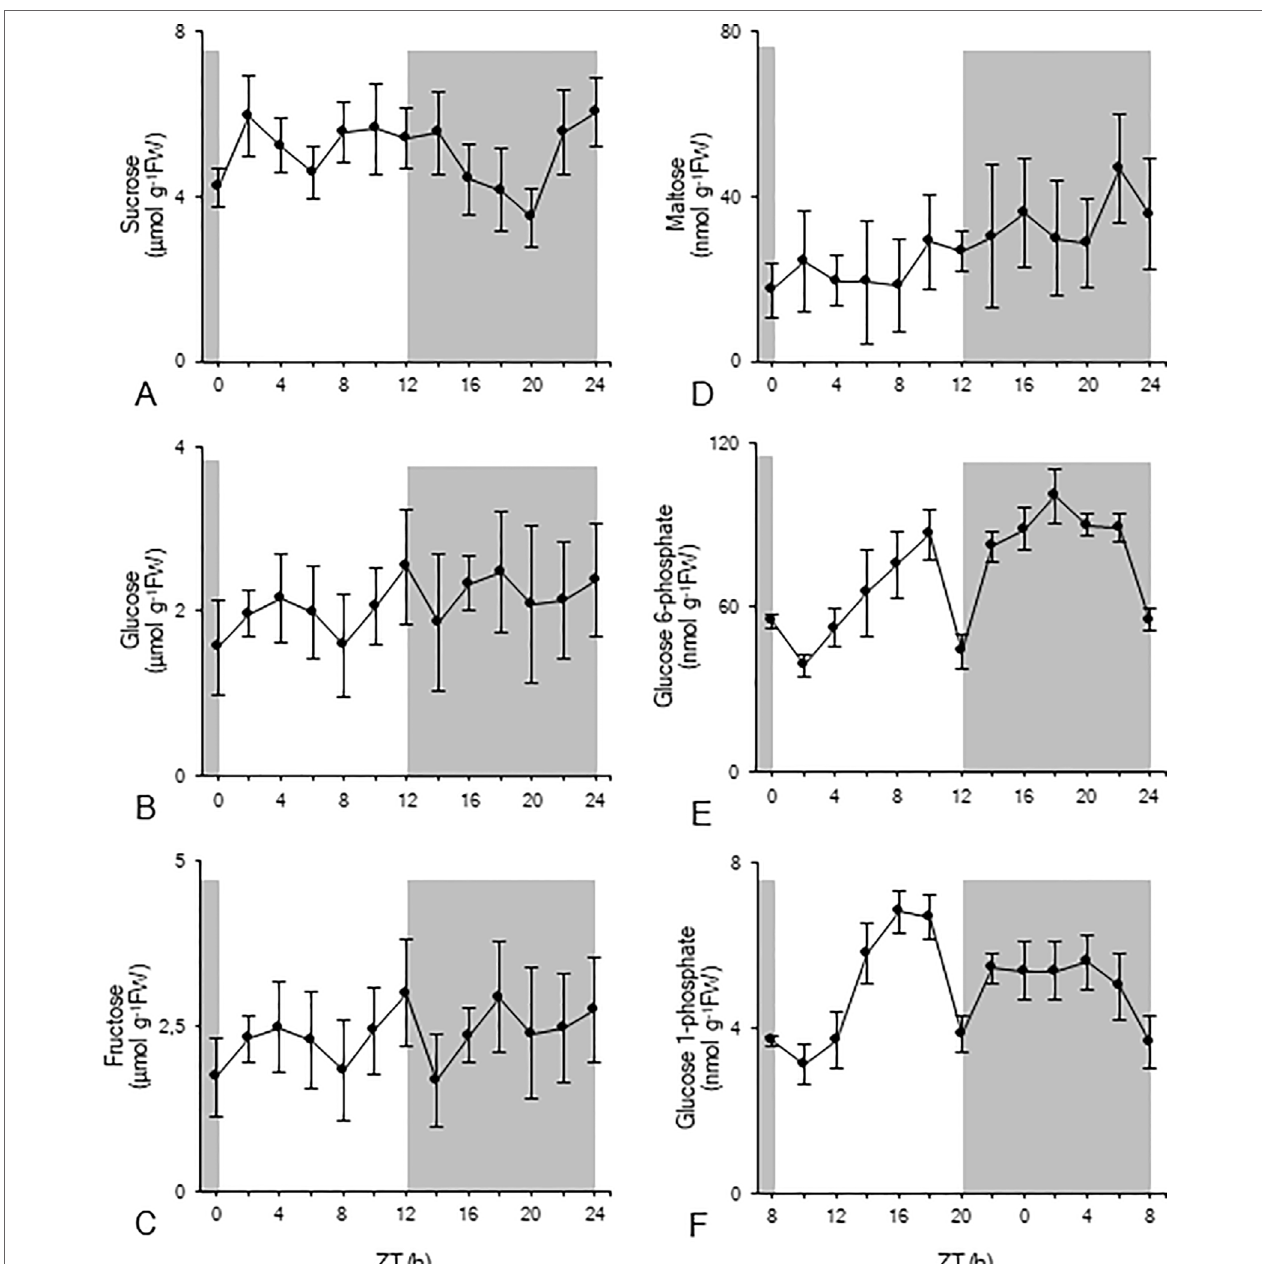
FigUrE 2 | Diel patterns of sucrose (µmol g -1 FW, A ), glucose (µmol g -1 FW, B ), fructose (µmol g -1 FW, C ), maltose (nmol g -1 FW, D ), glucose 6-phosphate (nmol g -1 FW, E ), and glucose 1-phosphate (nmol g -1 FW, F ) for young fully developed leaves of Phalaenopsis ‘Edessa’. The dark period is indicated in grey. Data are means ± SD (n = 5).